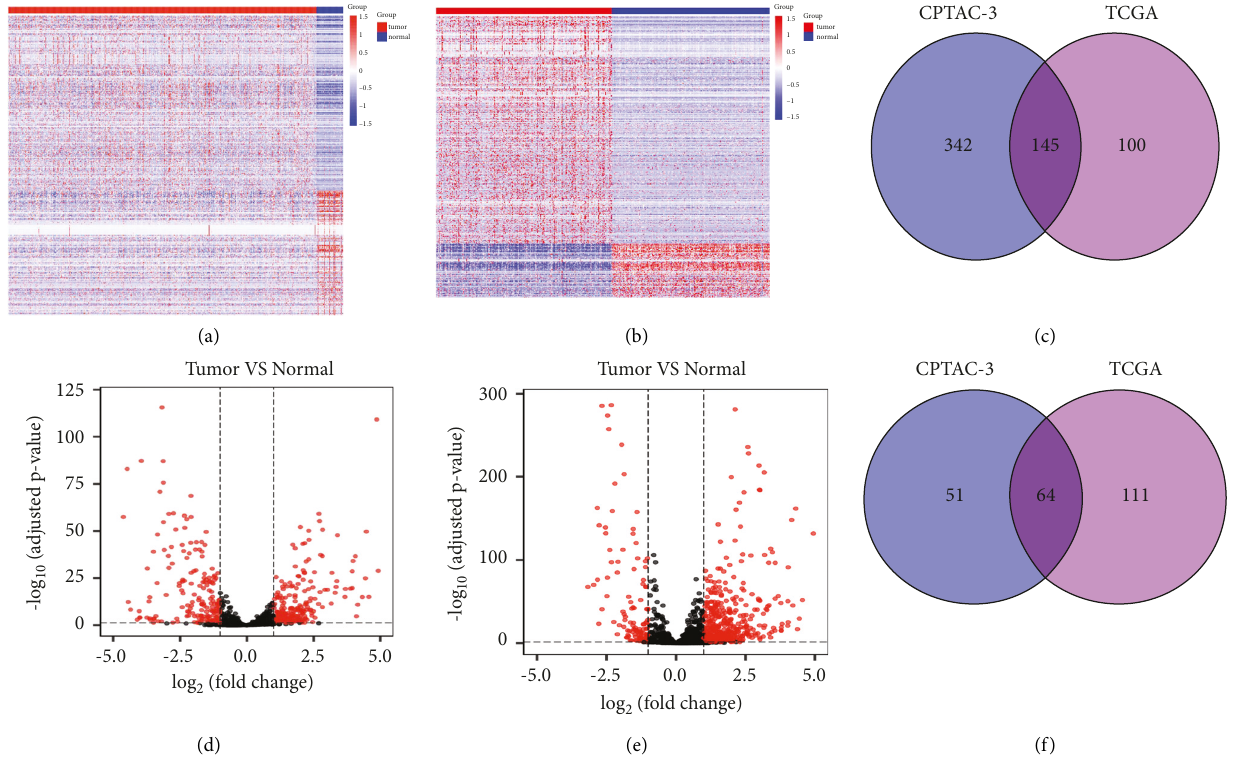
Figure 2: The GDC database, TCGA-LUAD and CPTAC-3, datasets were screened for 209 significantly differentially expressed candidate miRNAs. (a) Expression heatmap in TCGA; (b) expression heatmap in CPTAC-3; (c) volcano plot of the differentially expressed microRNA analysis of the TCGA data set; (d) volcano plot of the analysis of differential expression of CPTAC-3 data set. Red represents differentially expressed genes and black represents non-differentially expressed genes; (e) intersection of upregulated genes in tumors; (f) intersection of downregulated genes in